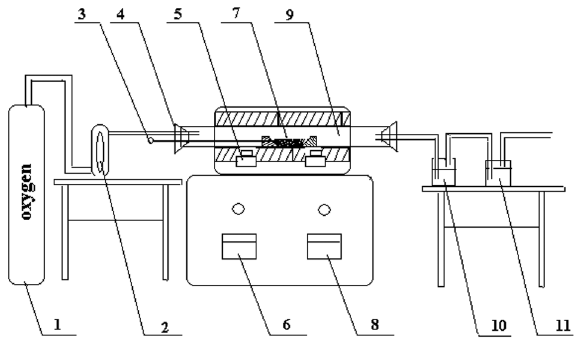
Figure 2 : Schematic diagram of the microwave reactor system.